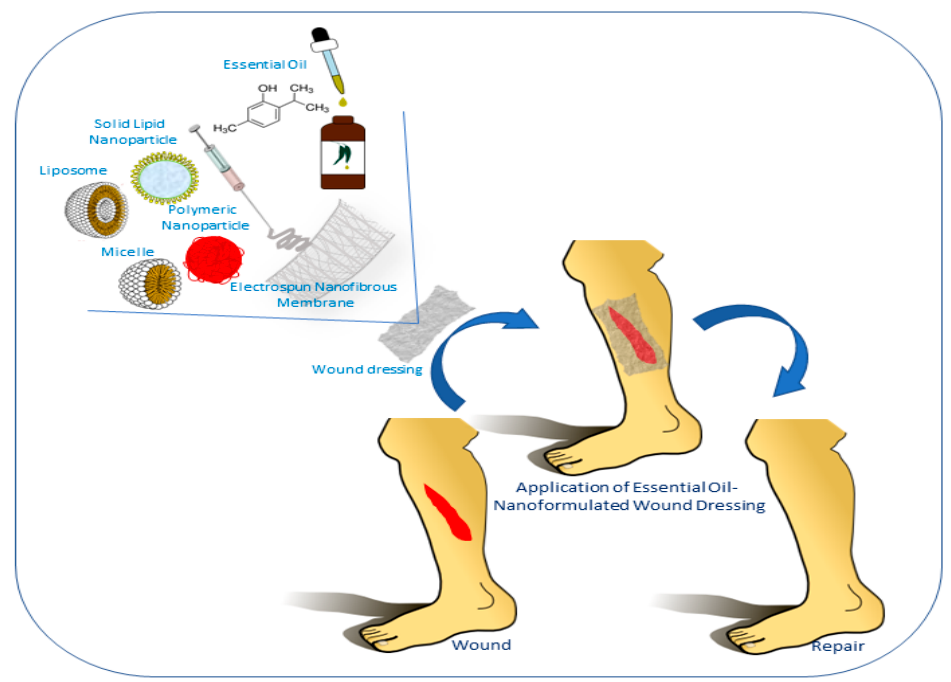
Figure 2. A diagram of wound tissue repair using nanomaterials loaded with essential oils at a target site.